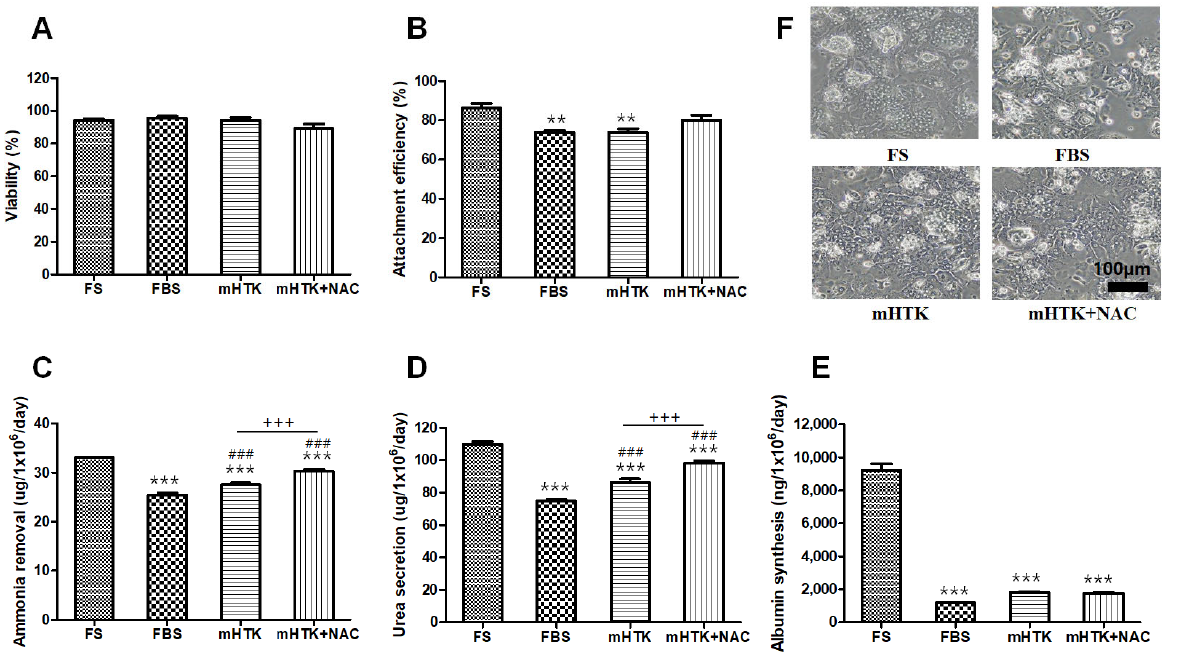
Figure 3. Effects of cryopreservation solutions on porcine hepatocyte spheroids’ viability and liver ‐ specific functions in post ‐ thaw cultures. Porcine hepatocyte spheroids were cryopreserved in three different freezing solutions containing 15% DMSO and stored for 1 year in liquid nitrogen. Porcine hepatocyte spheroids were thawed by rapid warming in a water bath and washed twice in thawing medium (first, hepatocyte spheroids were suspended in a warm medium with FBS rapidly, and then the medium was replaced with a warm HDM). ( A ) Cell viability, ( B ) attachment efficiency (assessed using a 3 ‐ (4,5 ‐ dimethyl thiazol ‐ 2 ‐ yl) ‐ 2,5 ‐ diphenyltetrazolium bromide assay), ( C ) ammonia re ‐ moval, ( D ) urea secretion, and ( E ) albumin synthesis were evaluated after thawing and plating for 24 h. Representative images of ( F ) porcine hepatocyte spheroids showing their morphology after plating and maintenance in culture for 24 h (×100). Fresh hepatocyte spheroids (upper left, FS) and hepatocytes cryopreserved using fetal bovine serum + DMSO (upper right, FBS), modified HTK + DMSO (lower left, mHTK), and modified HTK + N ‐ acetylcysteine + DMSO (lower right, mHTK + NAC). Statistical significance compared to fresh primary hepatocyte spheroids (FS): * p < 0.05, ** p < 0.01, *** p < 0.001, and compared the control freezing solution (FBS): # p < 0.05, ## p < 0.01, ### p < 0.001. Statistical significance: +++ p <